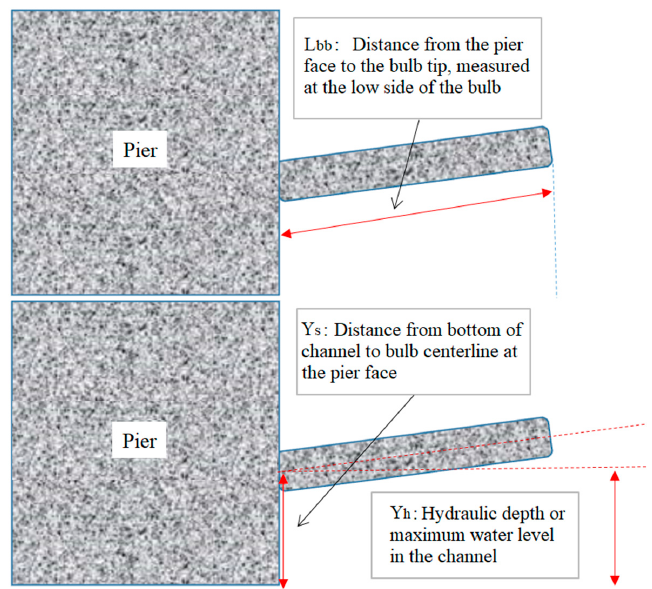
Figure 24. Normalized parameters’ description. Fluids 2019 , 4 , x FOR PEER REVIEW